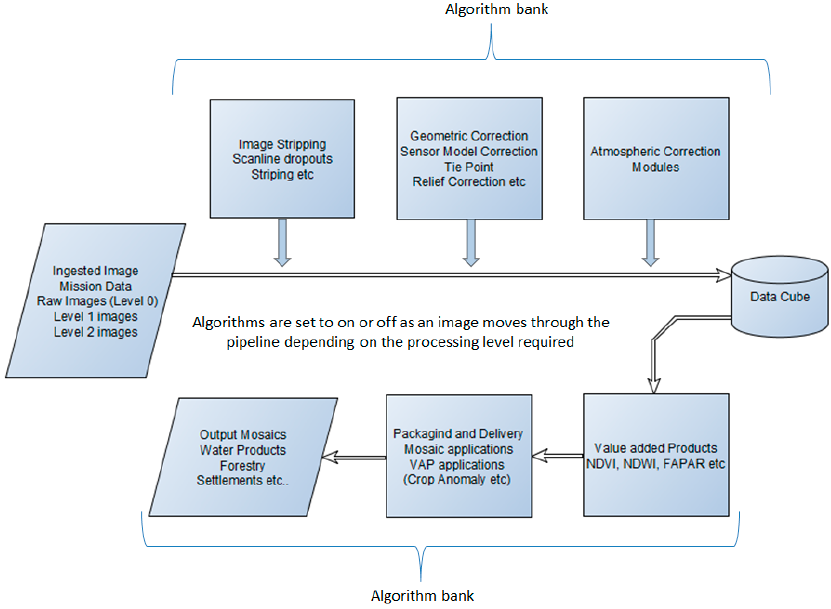
Figure 1. Multi-mission processing concept that is sensor-independent.